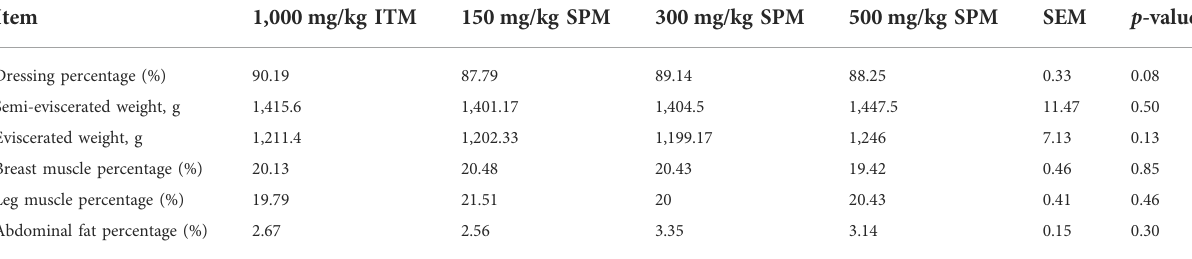
TABLE 4 Effect of supplementation of ITMs and SPMs in basal rations on slaughter performance of chickens.